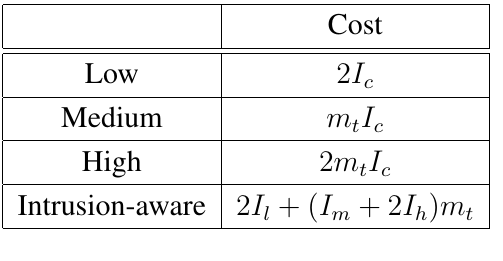
Table 2. Communication overhead of reliability modes.